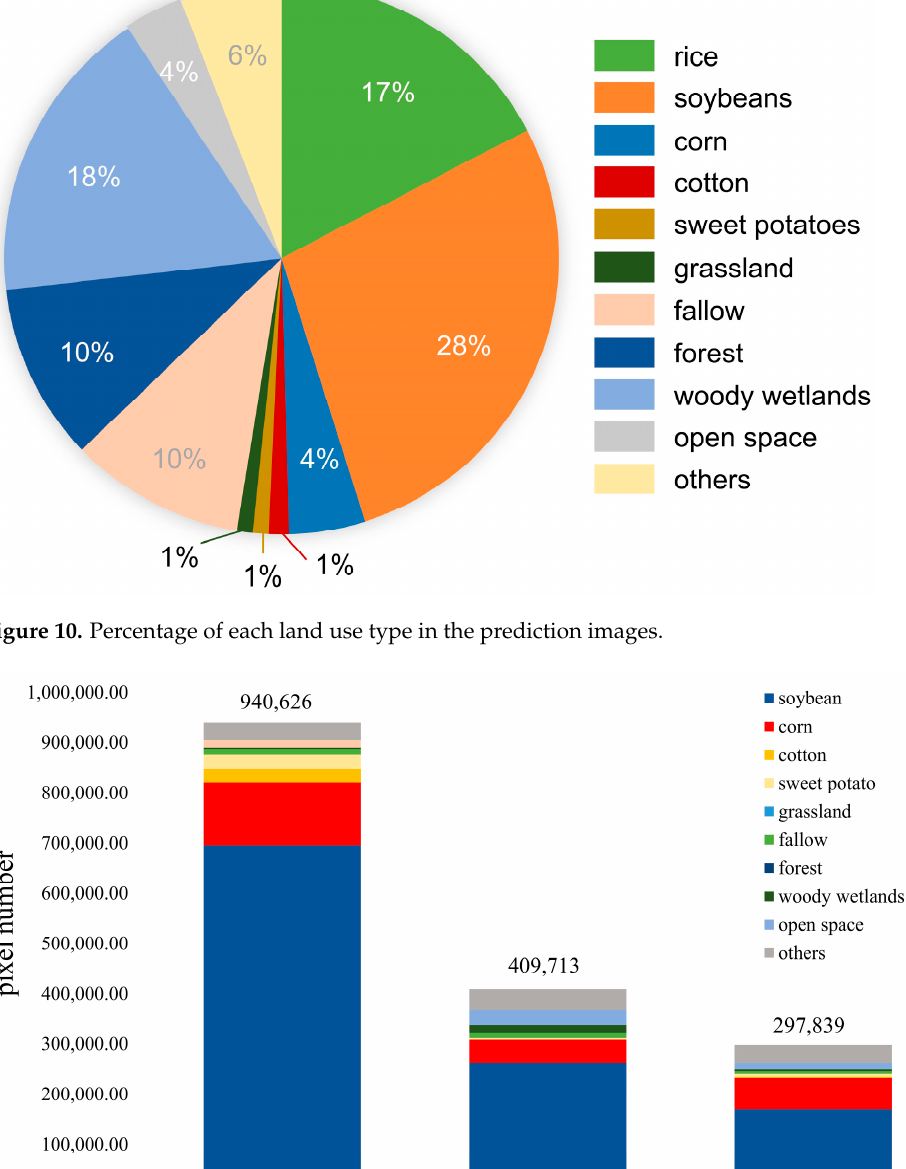
Figure 11. The number of the misidentified pixels in terms of the land use types.